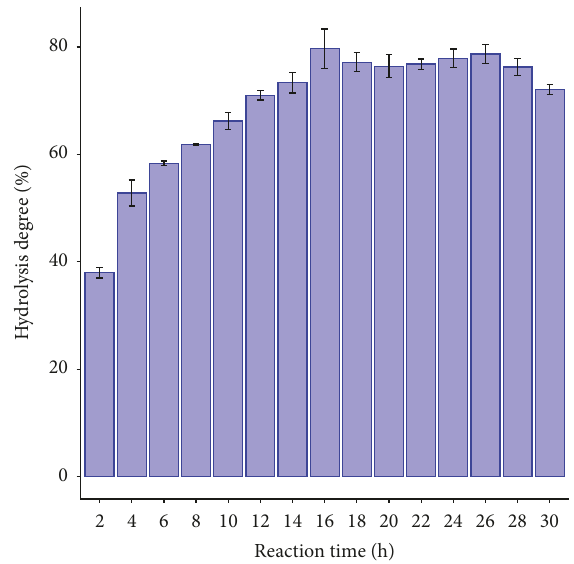
Figure 2: Time course of VCO hydrolysis catalyzed by CRL.